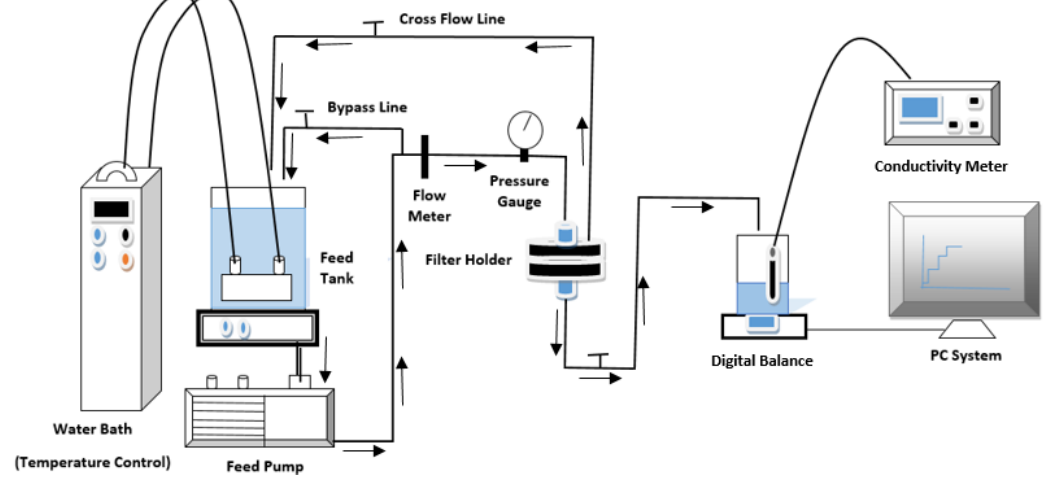
Figure 1. Graphical diagram of the desalination system.